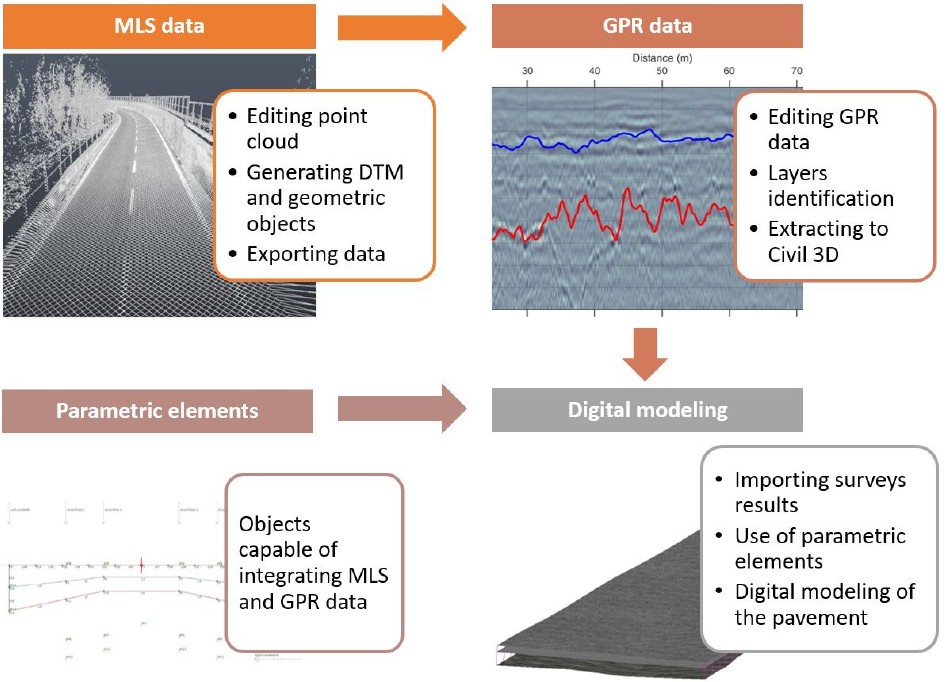
Figure 7. Proposed workflow for the integration of non-destructive survey data in a building information modeling (BIM)